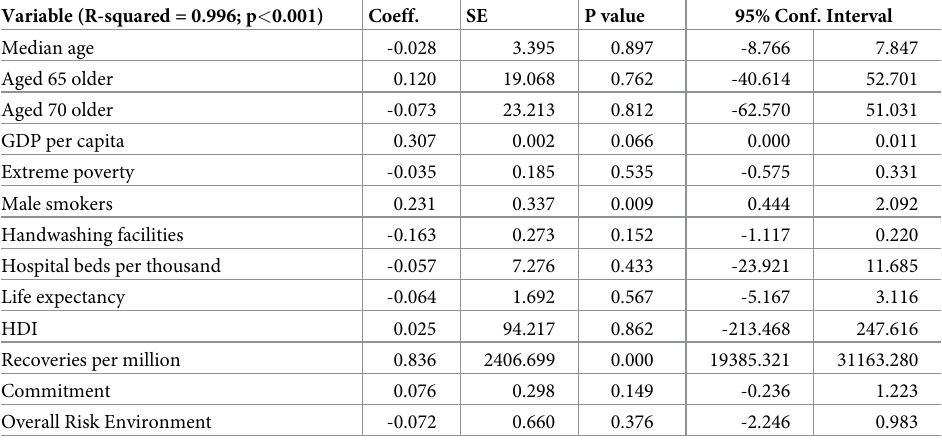
Table 3. Linear regression (multivariable) of total cases of deaths per million and predictor variables. Variable (R-squared = 0.996; p < 0.001) Coeff. SE P value 95% Conf.